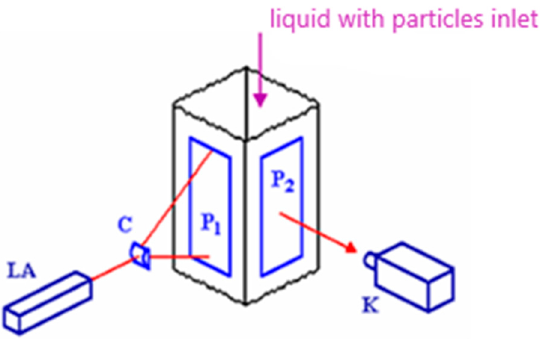
Figure 3. Flow visualization scheme (LA—laser, C—cylindrical lens creating a light knife, K—camera and P 1 and P 2 —windows).